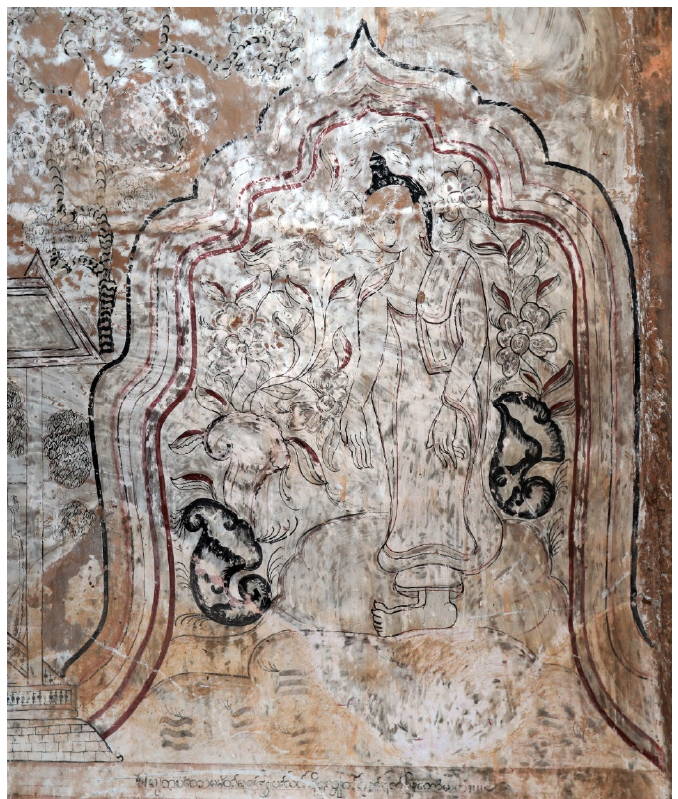
Figure 3. The Buddha standing in three-quarter view in front of the Bodhima ṇḍ a, the Second Week, Sulamani temple, Bagan.